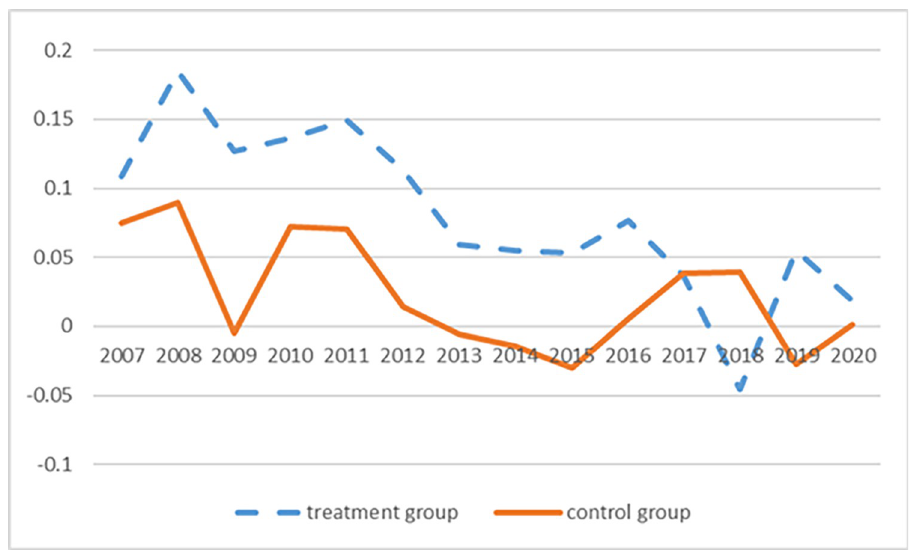
Fig 1. The average GDP growth rate of the Treatment Group and the Control Group.